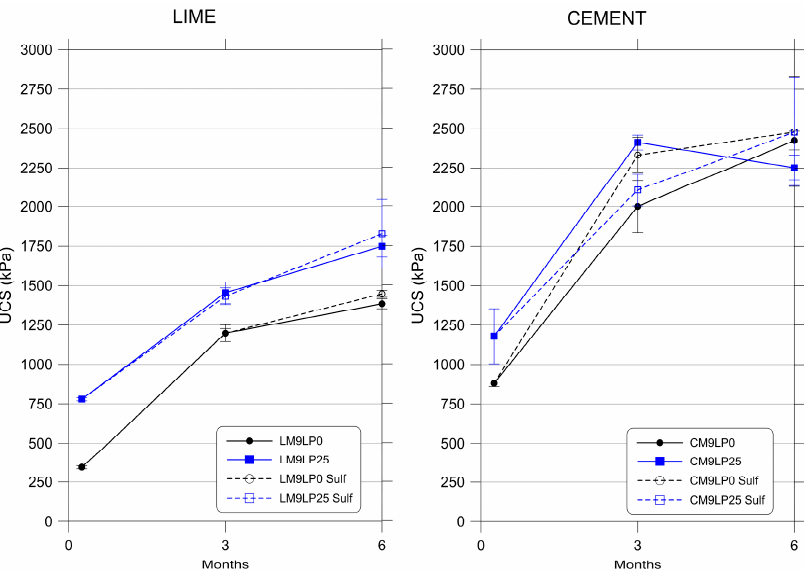
Figure 2. Unconfined compressive strength for lime and cement samples with and without industrial waste at 7 days and at 3 and 6